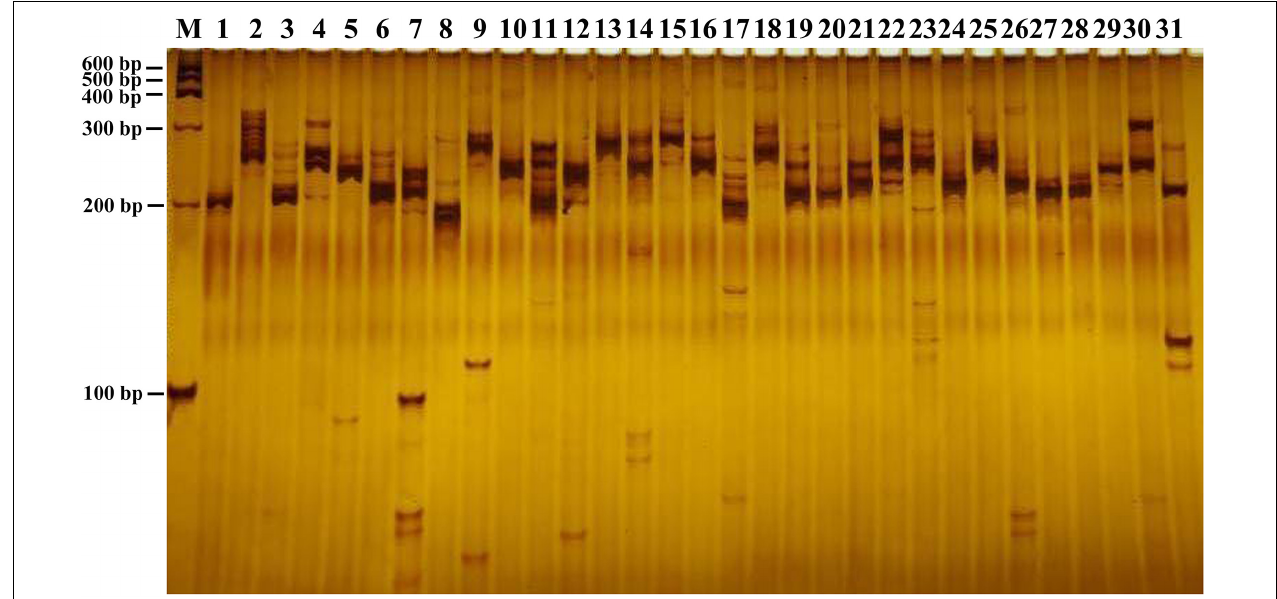
FIGURE 7 | SSR validation of B. striata . The 31 pairs of primers were